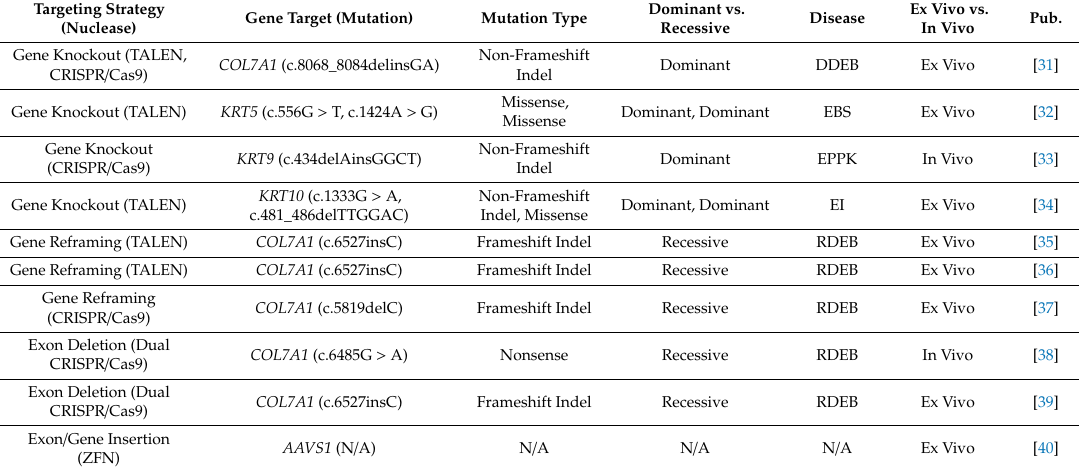
Table 1. Genome editing approaches for